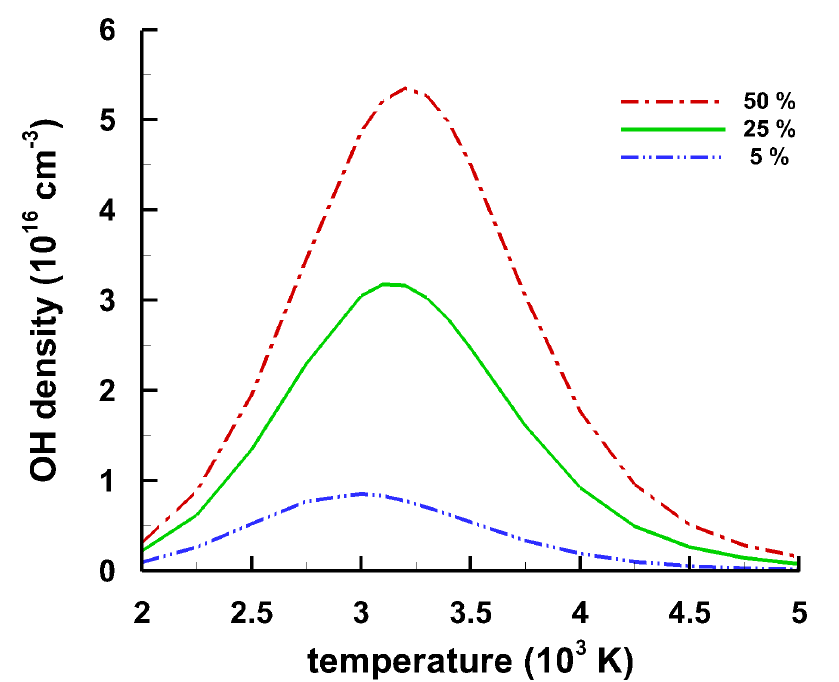
Figure 3. Calculated equilibrium hydroxyl (OH) density versus temperature. For air with 25% relative humidity, the OH density reaches a maximum of (cid:39) 3 × 10 16 cm − 3 at T (cid:39)